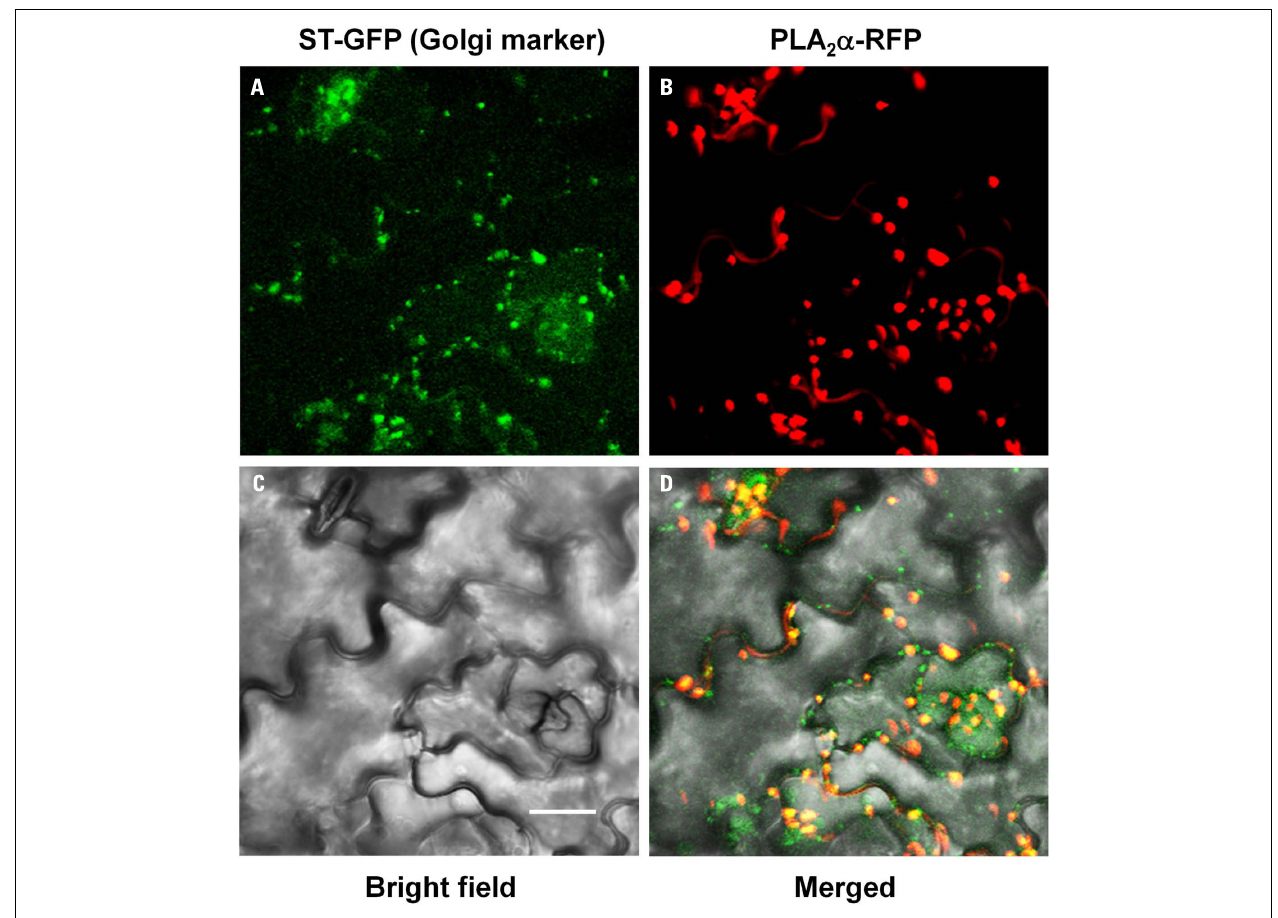
FIGURE 3 | Co-localization of PLA 2 α -RFP with ST-GFP, a Golgi body marker. Close-to-mature leaves of transgenic Arabidopsis plants expressing both PLA 2 α -RFP and ST-GFP were observed with a laser scanning confocal